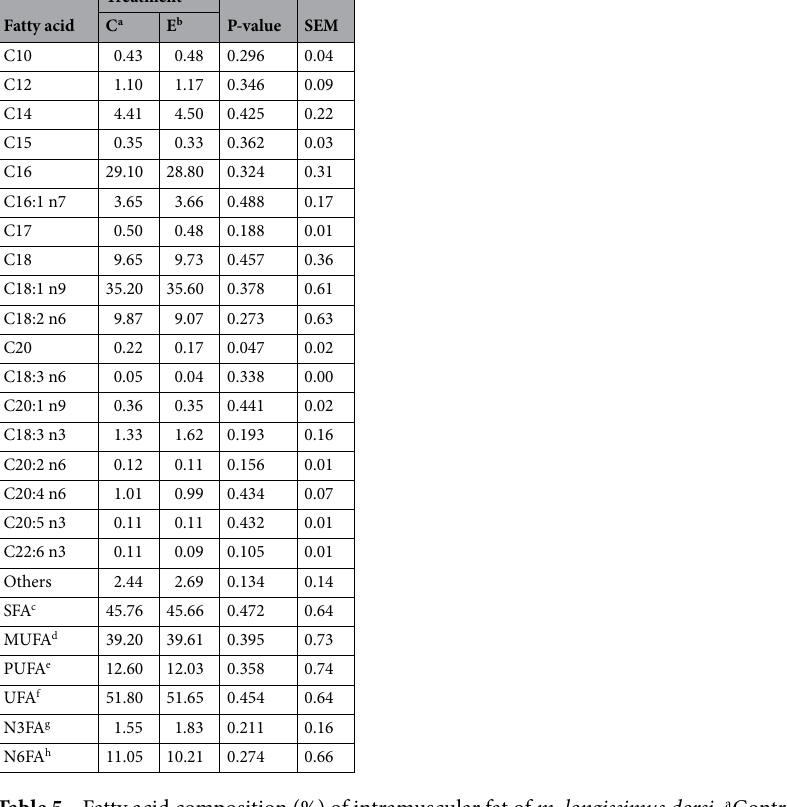
Table 5. Fatty acid composition (%) of intramuscular fat of m. longissimus dorsi. a Control group fed complete mixtures without halloysite. b Experimental group fed complete mixtures with halloysite addition. c Saturated fatty acids. d Monounsaturated fatty acids. e Polyunsaturated fatty acids. f Unsaturated fatty acids. g N − 3 fatty acids. h N − 6 fatty acids.